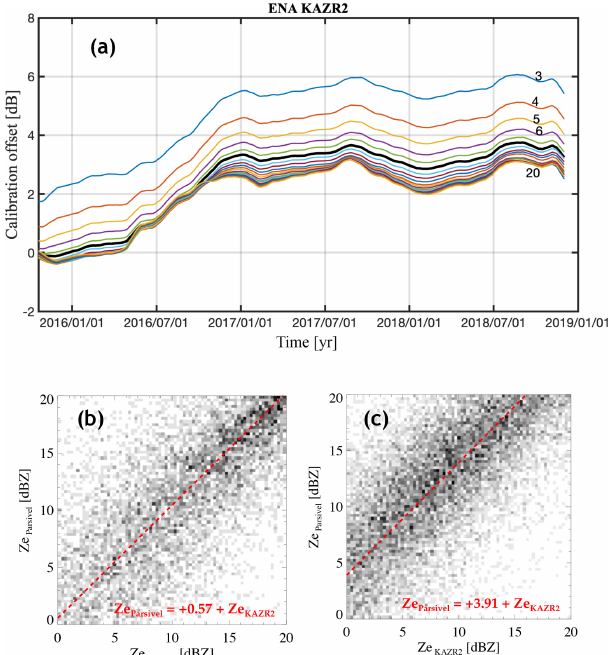
Figure A1. (a) The calibration offset between the KAZR2 and Par- sivel2 estimated using KAZR2 measurements from difference range gates (from the third to the 20th), (b) the calibration offset for the period 1 to 6 January 2016 using the eighth KAZR2 range gate, and (c) the calibration offset for the period 1 to 10 January 2017 using the eighth KAZR2 range gate. These two periods correspond to the periods used for the ARM–CloudSat calibration offsets shown in Fig.